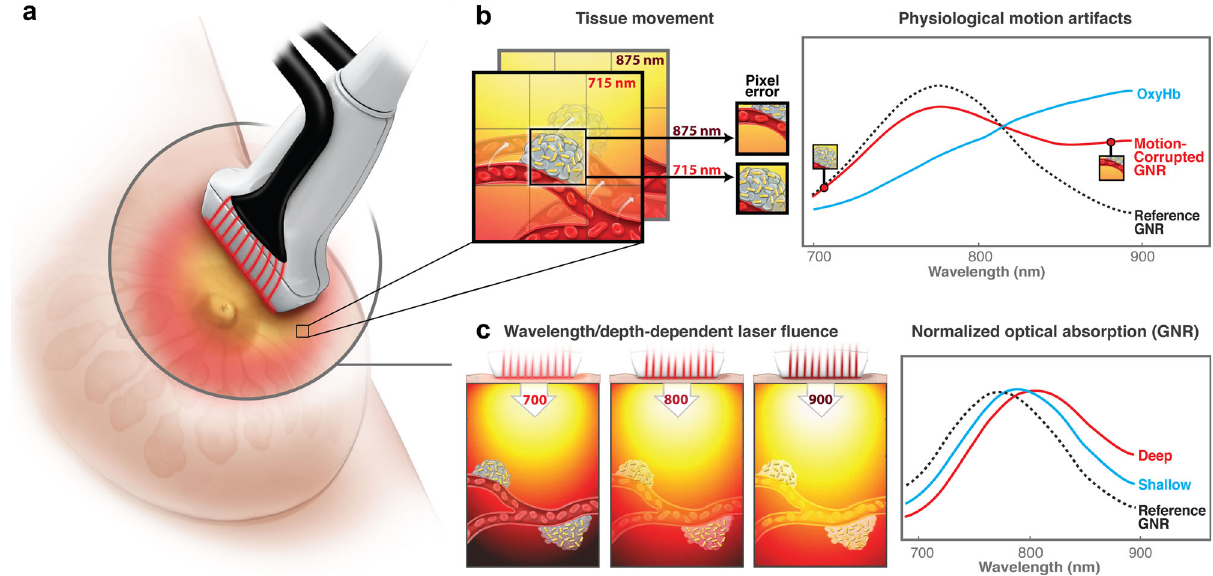
Fig. 1 Effects of wavelength-dependent optical fl uence variations and tissue motion on quantitative spectroscopic measurements. a Schematic of conventional interleaved photoacoustic-ultrasound (PAUS) imaging: pulsed laser radiation irradiates the tissue simultaneously from all fi bers surrounding the US detector, thus creating broad-beam illumination. b Spectroscopic PAUS requires sequential multi-wavelength illumination of moving tissue. As shown herein, tissue motion during spectroscopic acquisition can corrupt measurements of the concentration of different chromophores (blood and gold nanorods (GNR), for example) in an image pixel. c Wavelength- and depth-dependent optical fl uence in tissue can strongly affect measurements of optical absorption spectra. In this example, the GNR spectrum changes with increasing image